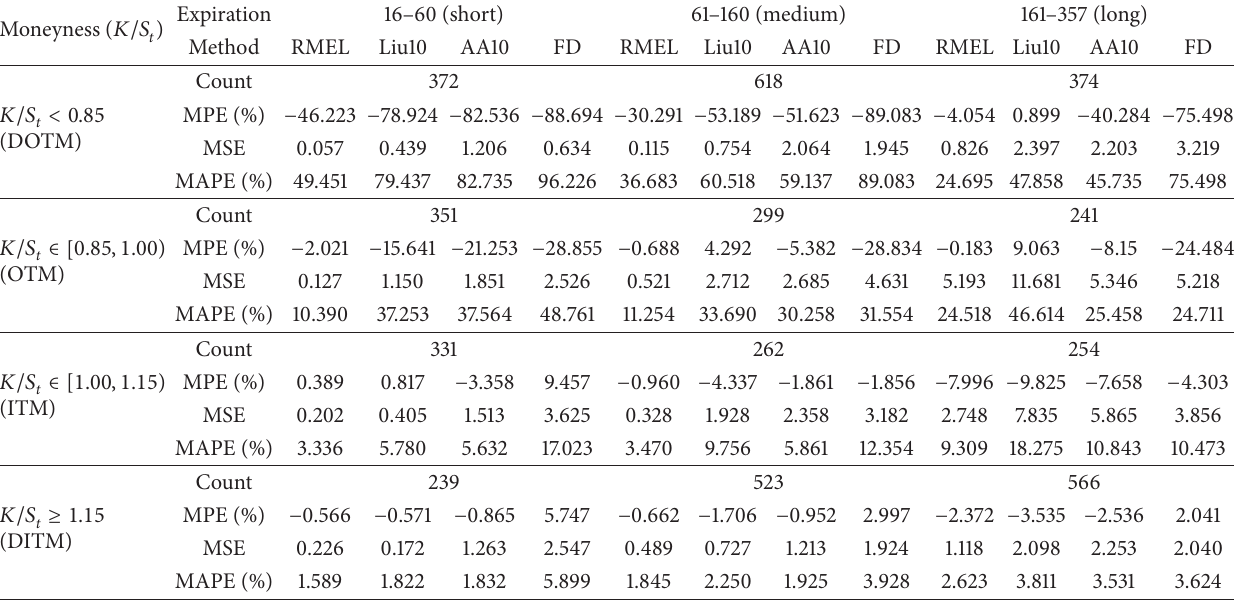
Table 6: MPE, MSE, and MAPE of IBM put price estimates compared to IBM market prices for a range of moneyness and time to expiration. Moneyness (𝐾/𝑆 𝑡 )